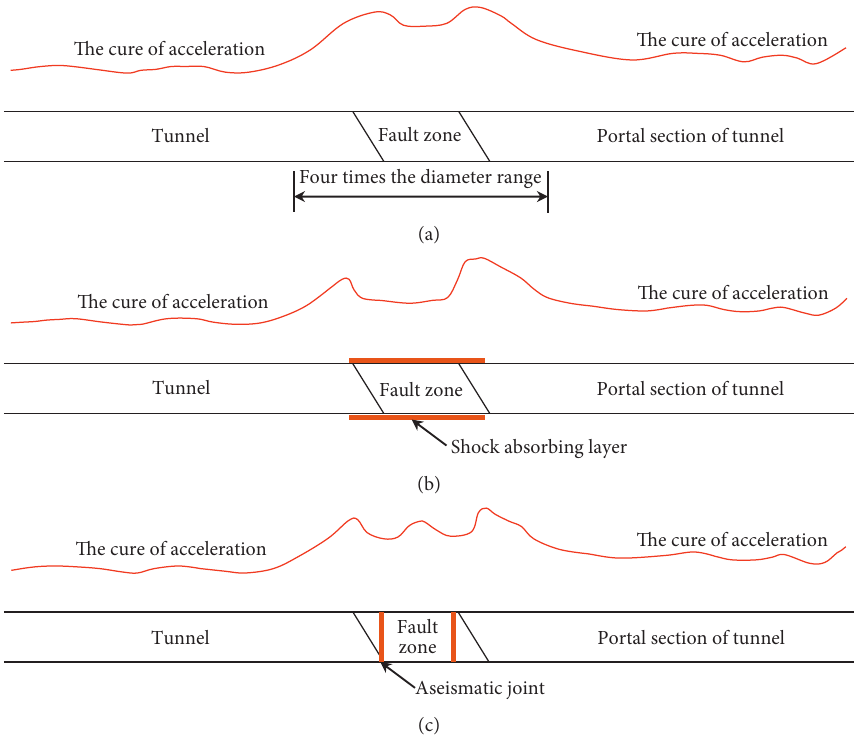
Figure 9: Peak acceleration distribution at the tunnel roof (left tunnel). (a) Without seismic measurements. (b) With shock absorption layer. (c) With aseismic seam.